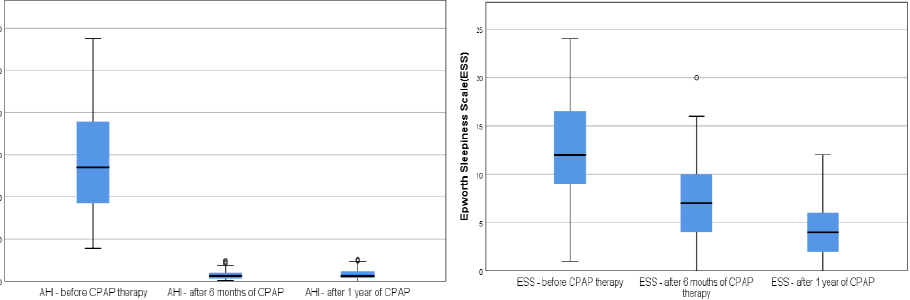
Figure 2. Boxplot showing the difference inAHI and ESS progression following CPAP therapy. AHI, apnea hypopnea index; ESS, epworth sleepiness scale. The circles represent the outliners of the